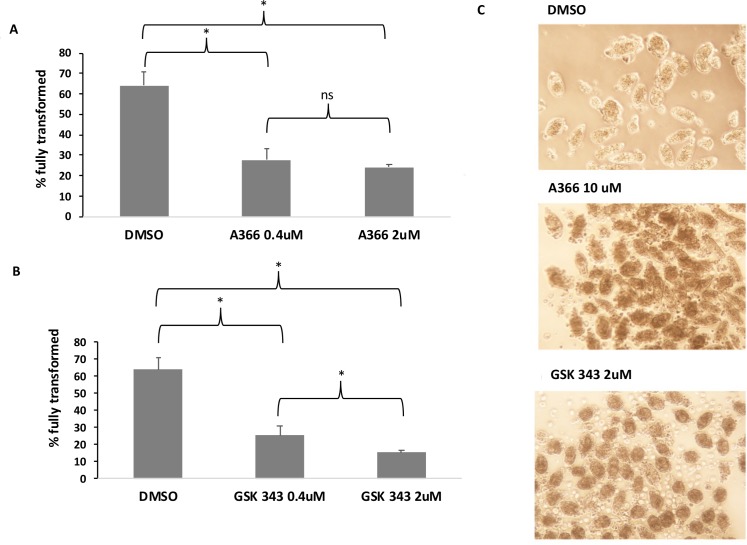
Histone methyltransferase inhibitors block miracidium to primary sprorocyst transformation.Each treatment was set up in triplicate and parasites were cultured in CBSS with 1% DMSO at a controlled temperature of 26°C (in the dark). An ANOVA followed by post hoc analysis with Tukey’s multiple comparison test was performed to infer statistical significance; *p<0.005. A. Effect of 0.4 μM of A366, 2 μM of A366 and DMSO (negative control). B. Effect of 0.4 μM of GSK343, 0.4 μM of GSK343 and DMSO (negative control). C. Photomicrographs of miracidia to sporocyst transition in the presence of histone methyltransferase inhibitors. Miracidia transformed in the presence of DMSO (negative control) show normal transformation into sporocysts, but fail to lose their ciliated plates and do not develop into primary sporocysts in the presence of of A366 and GSK343 (10 μM). Representative images were acquired at low power (10X objective).